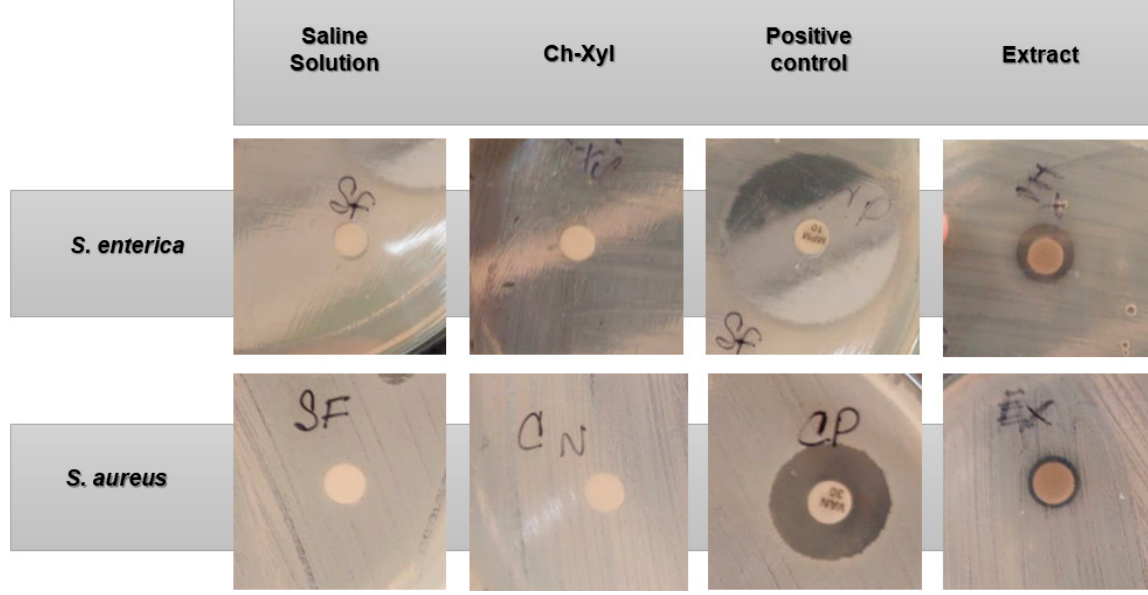
Figure 5. Disc-diffusion antimicrobial sensitivity. Representation of halos of inhibition for S. enterica and S. aureus in four treatments: saline solution, DES only (Ch-Xyl), positive control (meropen and vancomycin respectively), and optimized extract.